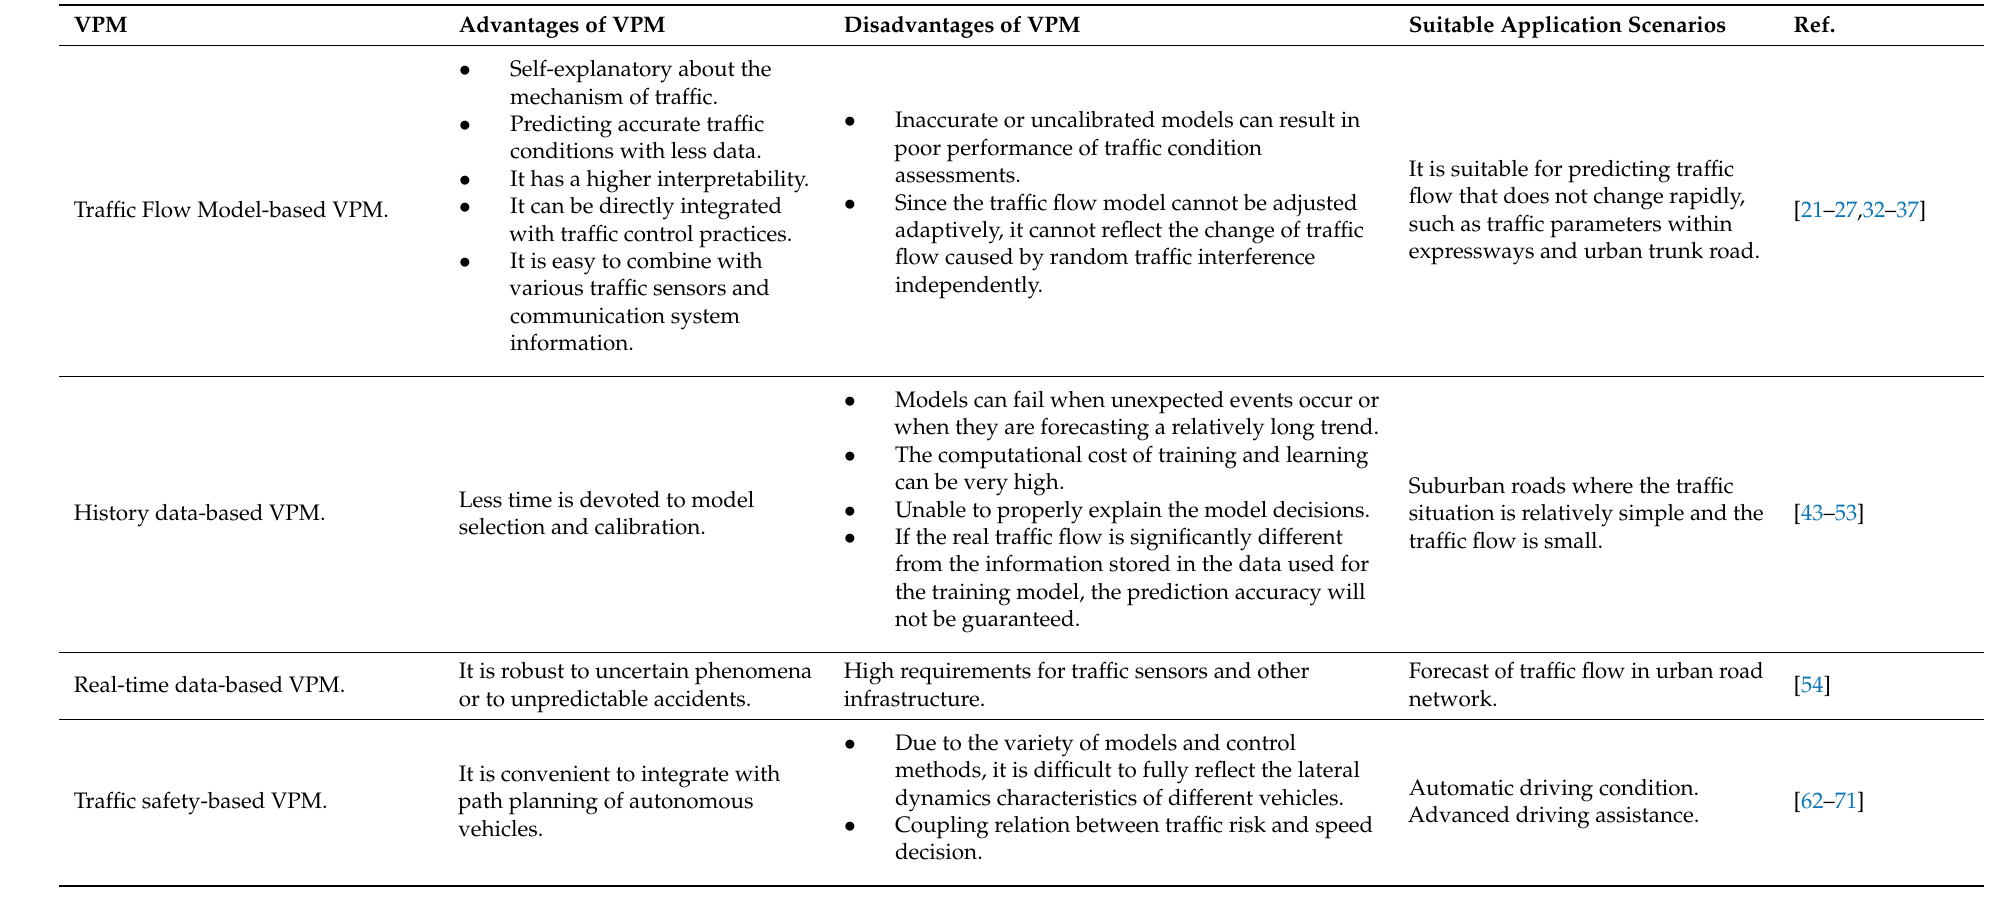
Table 1. Advantages and disadvantages of different velocity prediction methods